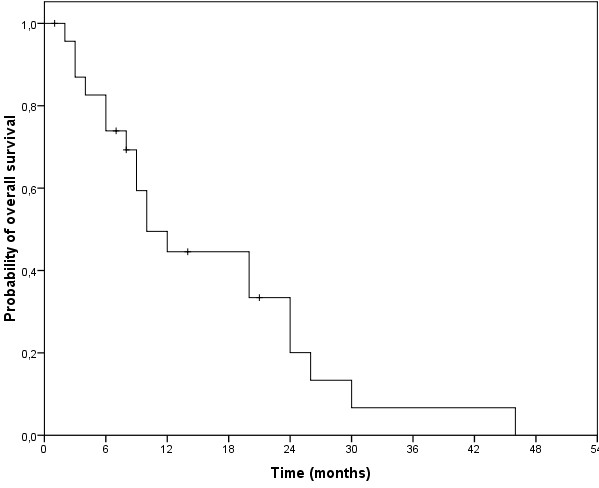
Kaplan-Meier-Estimation of overall survival.